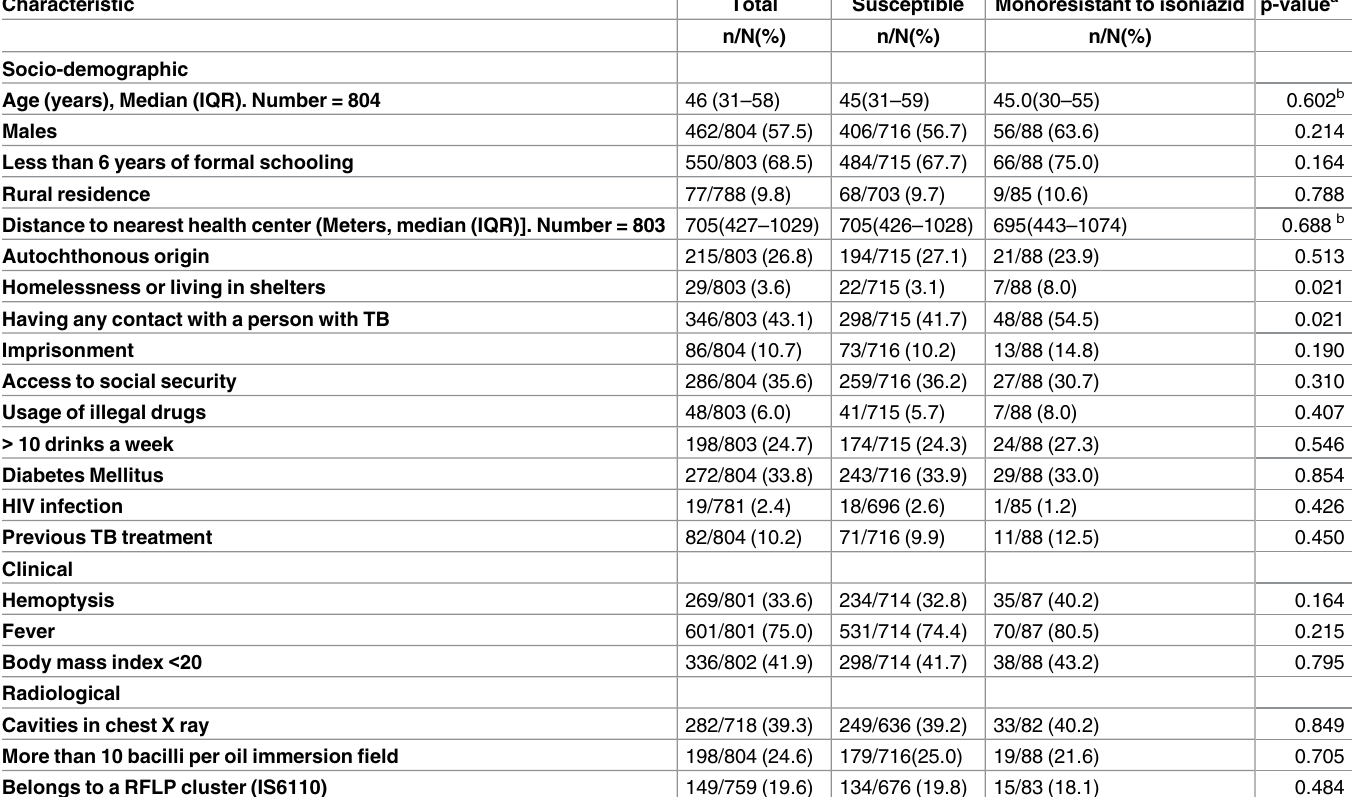
Table 2. Socio-demographic, Clinical, and Radiological Characteristics of Patients with Pulmonary Tuberculosis, According to Type of Resis- tance. Orizaba, Veracruz 1995–2010. Characteristic